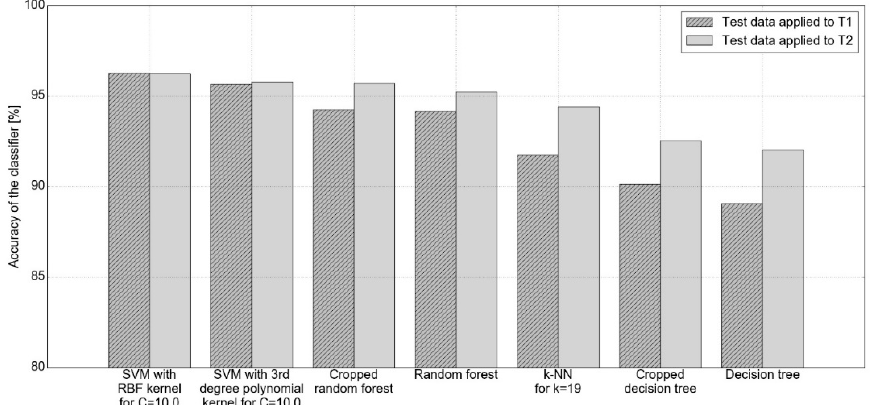
Figure 8. Comparison of the classifiers’ accuracy obtained for test scenarios T 1 and T 2, i.e., for the test data recorder for individuals who did not record the training data (T_12_set). Classifiers accuracy for the test data collected directly from the accelerometer and gyroscope (vectors with six